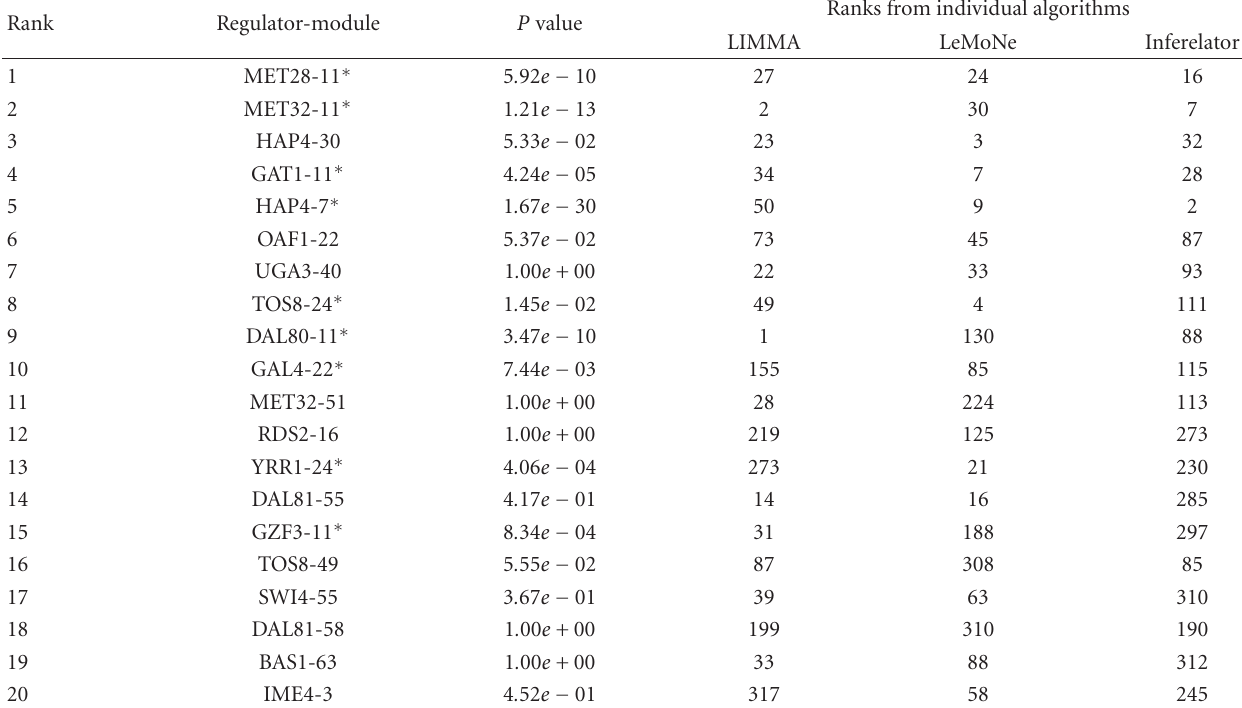
Table 3: Top twenty regulator-module interactions as given by the intersection method. ∗ Records represent true positives at the P value threshold of 0.05.